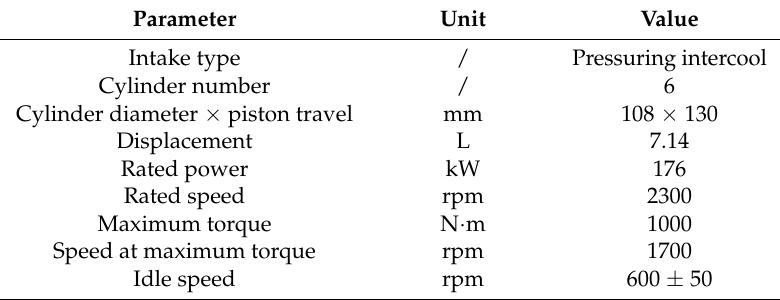
Table 1. Parameters of the